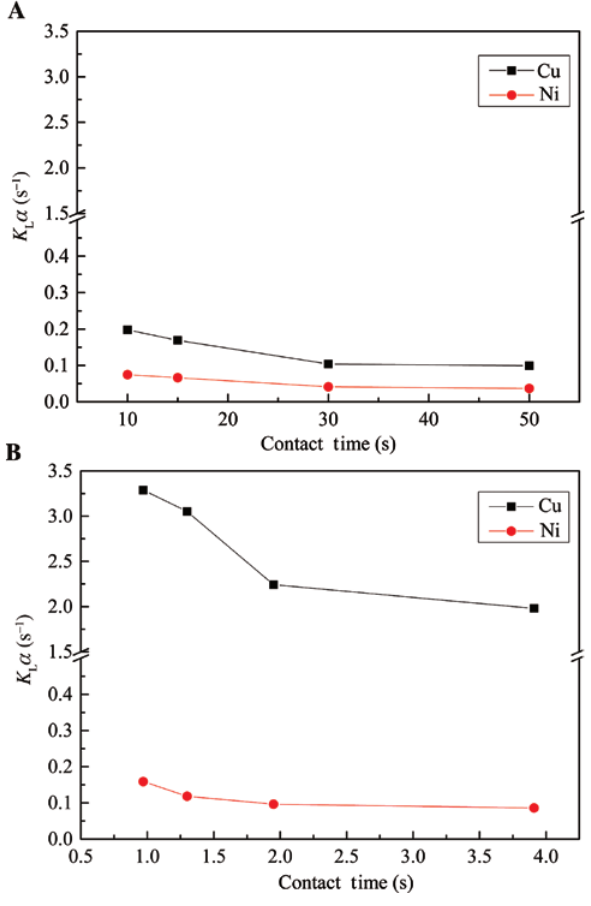
Figure 11: Overall volumetric mass transfer coefficient versus contact time in (A) separating funnel and (B) microreactor.